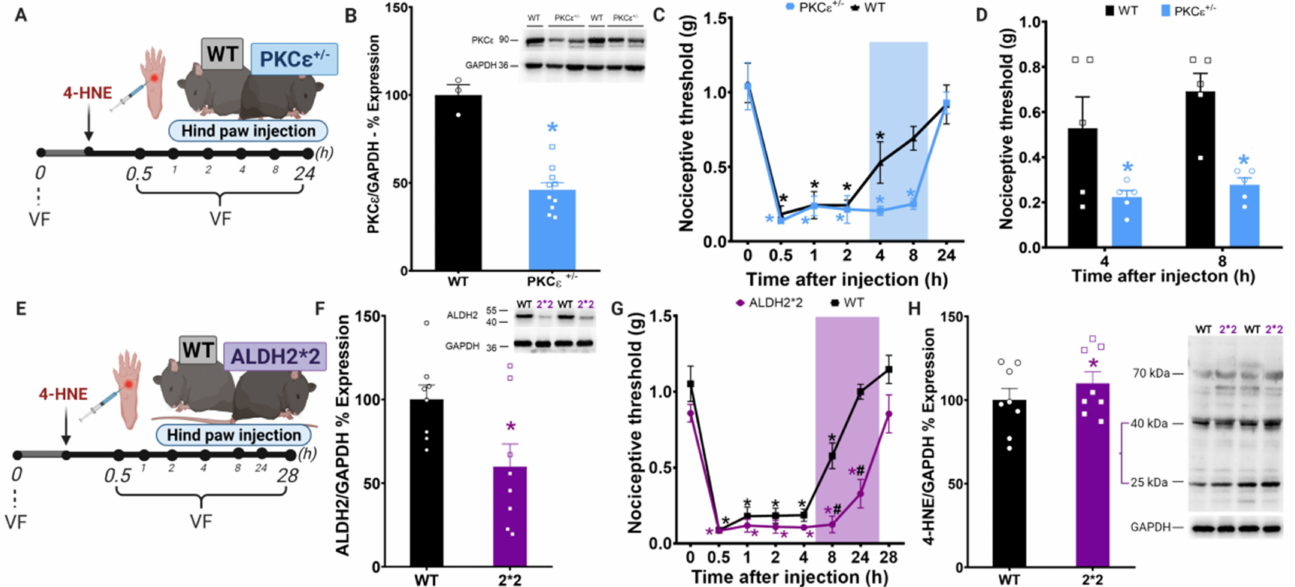
Figure 2. Disruption of PKC ε -ALDH2 axis contributes to 4-HNE-induced mechanical hypersensitivity. ( A ) Schematic panel of drug administration and von Frey filament test (VF) in PKC ε +/ − animals. ( B ) PKC ε expression in the paw tissue of wild-type and PKC ε +/ − mice. T-test * p <0.05 compared to wild type. n = 8/group. ( C ) Time-course of 4-HNE-induced mechanical hypersensitivity (60 nmol/paw) in PKC ε +/ − . Two-way analysis of variance (ANOVA) with post-hoc testing by Tukey * p < 0.05 compared to baseline. n = 8/group. ( D ) PKC ε +/ − animals have more hypersensitivity when compared to wild-type animals at 4 and 8 h after 4-HNE injection. One-way analysis of variance (ANOVA) with post-hoc testing by Tukey. * p < 0.05 compared to wild-type. n = 8/group. ( E ) Schematic panel of drug administration and von Frey filament test in ALDH2*2 animals (mice with impairment in ALDH2 activity). n = 8/group. ( F ) ALDH2 expression in paw tissues of wild type and ALDH2*2. T -test * p < 0.05 compared to wild type. n = 8/group. ( G ) Impairment in ALDH2 activity (ALDH2*2) increases the hypersensitivity when compared to wild-type animals at 8 and 24 h after 4-HNE injection. Two-way analysis of variance (ANOVA) with post-hoc testing by Tukey * p < 0.05 compared to baseline, # p < 0.05 compared to wild-type. n = 8/group. ( H ) representative western blot and % change in 4-HNE protein adducts in proteins extracted from paws treated with 4-HNE (60 nmol/paw) of wild type and ALDH2*2 mice (GAPDH used as loading control). T -test * p < 0.05 compared to wild type. n = 8/group. All data are means ± SEM. Pain assessment was carried out by an observer blinded to the experimental